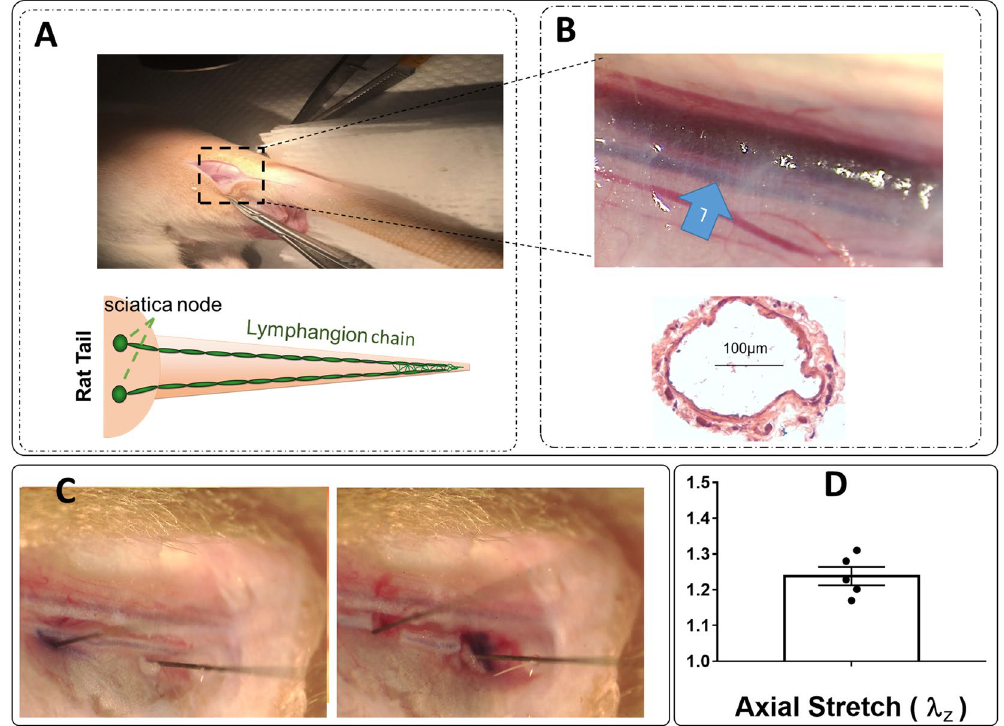
Figure 1. Two chains of lymphatic collectors run parallel in a rat tail (Panel A). An image of the location where an incision was made to gain access to the lymphatic vessel close to the base of tail showing that the lymphatic vessel runs parallel to the tail vein and arteries along with an image of H&E staining for a section of vessel (Panel B), an image showing lymphatic vessels from rat tails are under axial stretch in situ where insect pins mark the length of vessel prior to the dissection (Panel C), measurements of in situ axial stretch (Panel D, n = 5) where, each point represents a measurement in a different animal, are